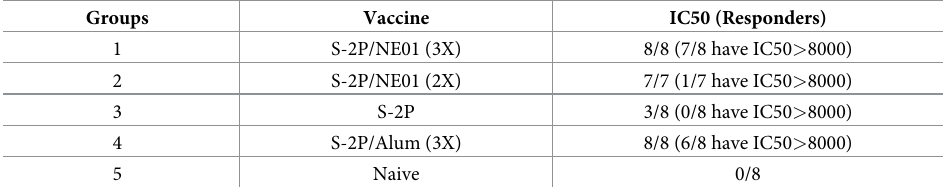
Table 1. Pseudovirus SARS-CoV-2 neutralization activity of serum from